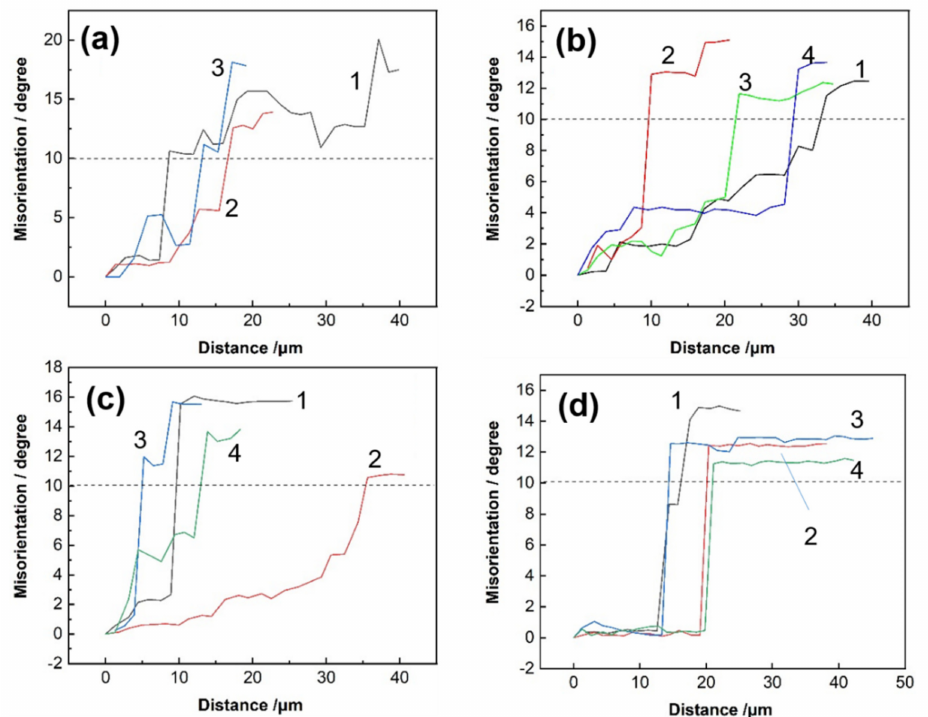
Figure 11. Misorientation cumulative images between deformed subgrains of spray-deposited 7055 aluminum alloy under hot compression conditions of 300 ◦ C/0.001 s − 1 ( a ), 400 ◦ C/0.1 s − 1 ( b ), 450 ◦ C/5 s − 1 ( c ) and 450 ◦ C/0.001 s − 1 ( d ). (Curves 1, 2, 3 and 4 in each image are the misorientation cumulative routes in Figure 10).